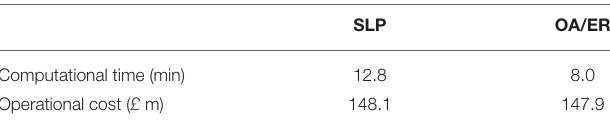
TABLE 3 | Computational performance for optimization of a day through different solving